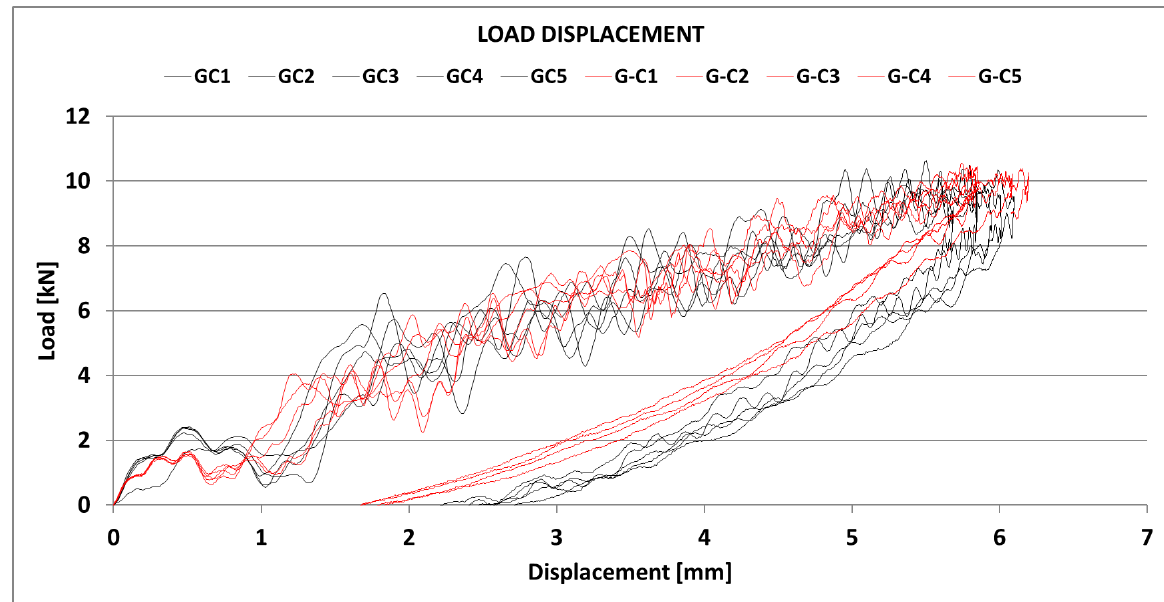
Table 2. Maximum load, E i , E p , E a , and D I of each hybrid composite tested sample. Config.